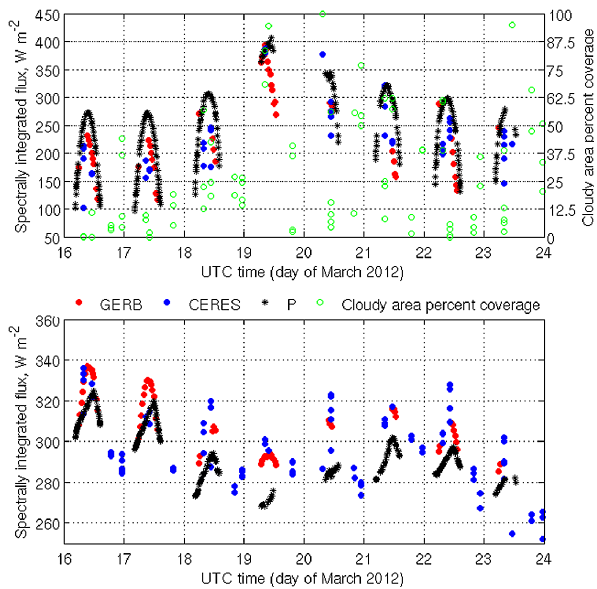
Figure 7. SW (top panel) and LW (bottom panel) surface down- welling fluxes at KAUST for the perturbed experiment (P, blue) and in situ measurements (Obs, red). Aeronet SDA column AOD at 500nm (top panel, green) is plotted against the right vertical axis.